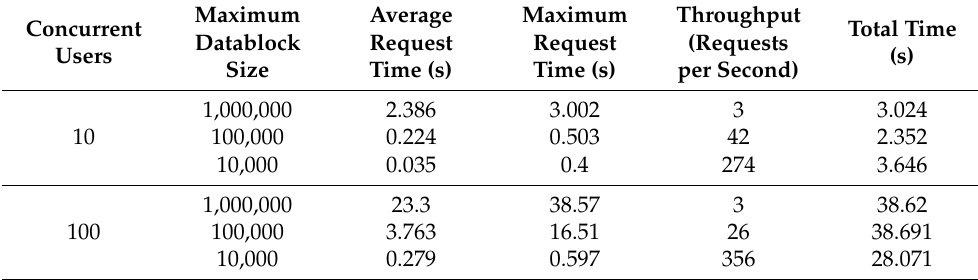
Table 7. Results of the concurrent requests test in PostgreSQL.